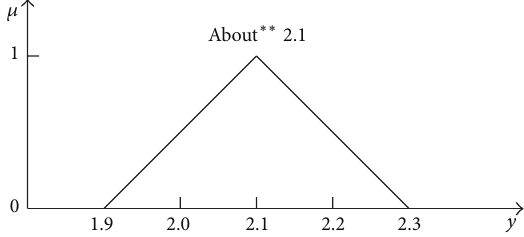
Figure 16: 2D representation of the full 4D addition result obtained with use of the extension principle (34) both for the case of two independent numbers and dependent numbers constrained by the order relation 𝑥 2 > 𝑥 1